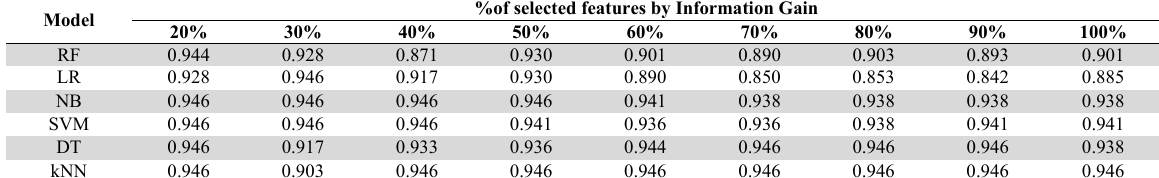
Results of Accuracy evaluation measure against different feature sets Model